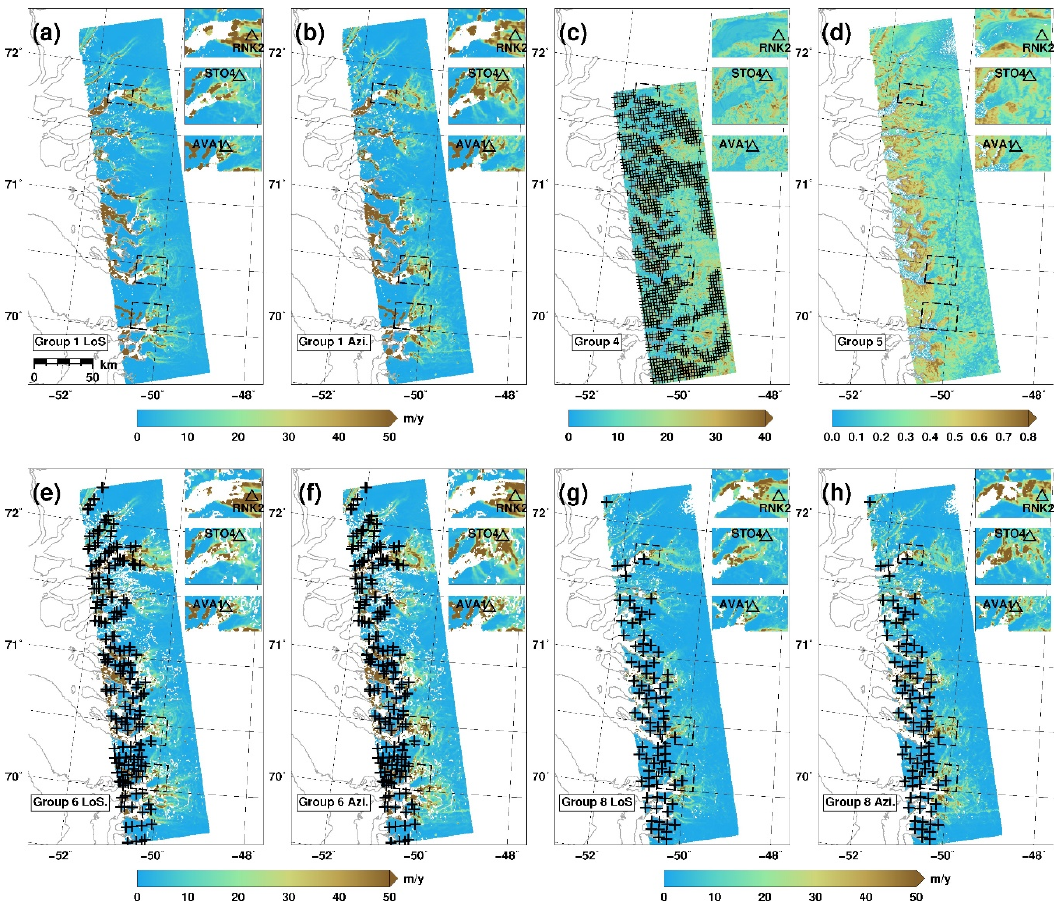
Figure 17. Task 4 quality parameters. Groups 1 slant ‐ range ( a ) and azimuth error standard deviation ( b ); group 4 cross ‐ correlation signal to noise ratio ( c ); group 5 normalized cross ‐ correlation amplitude ( d ); group 6 slant ‐ range ( e ) and azimuth error standard deviation ( f ); group 8 slant ‐ range ( g ) and azimuth error standard deviation ( h ). Triangles represent the GPS stations used for validation. Crosses represent GCPs used for velocity calibration.